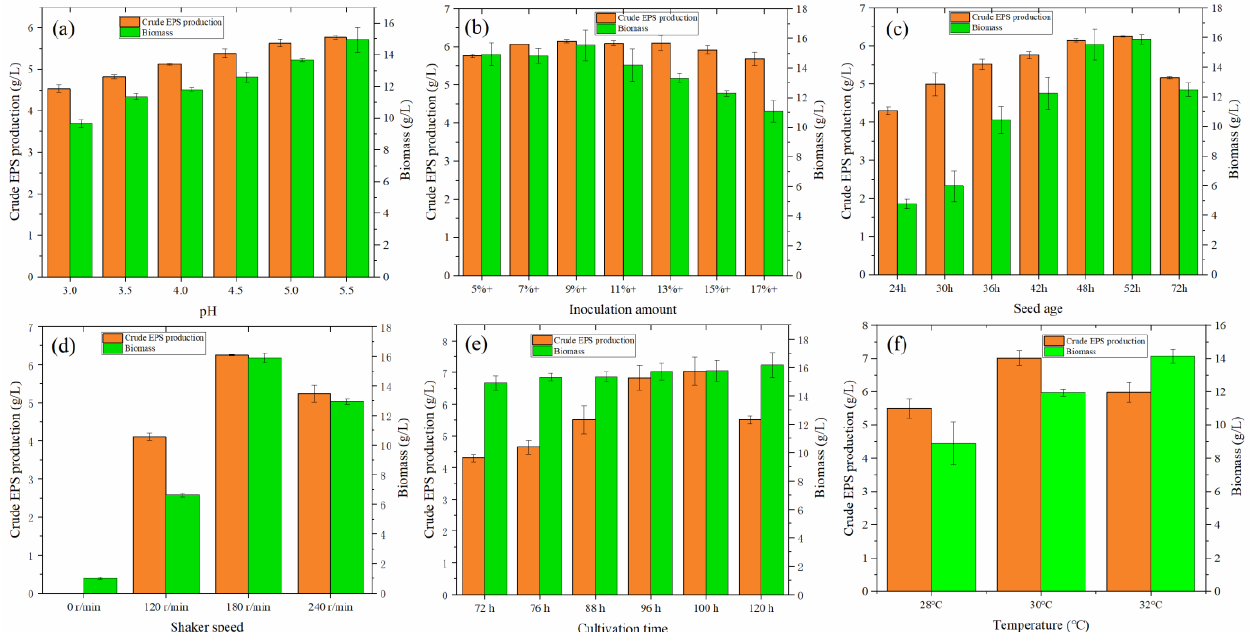
Figure 4. ( a ) Effect of initial pH on the production of crude EPS and biomass of MAL. ( b ) Effect of inoculation amount on the crude EPS and biomass produced by MAL. ( c ) Effect of seed age on the crude EPS and biomass of MAL. ( d ) Effect of shaker speed on the crude EPS and biomass produced by MAL. ( e ) Effect of culture time on the crude EPS and biomass produced by MAL. ( f ) Effect of temperature on the crude EPS and biomass produced by MAL